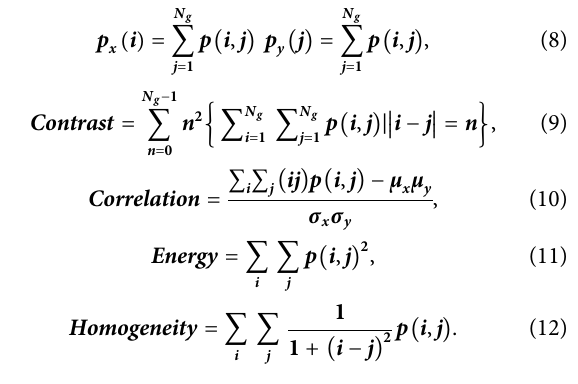
0.40, 40×/NA 0.65, and 60×/NA 0.80, as shown in Figure 2 . Then,